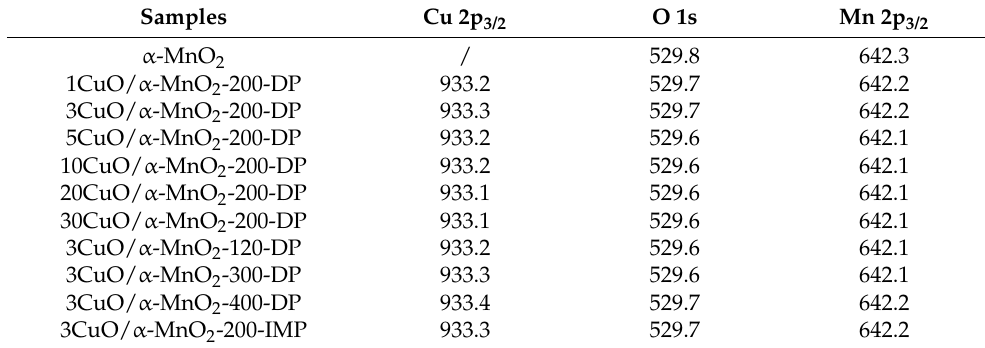
Table 3. Binding energies of surface elements in x CuO/ α -MnO 2 - T